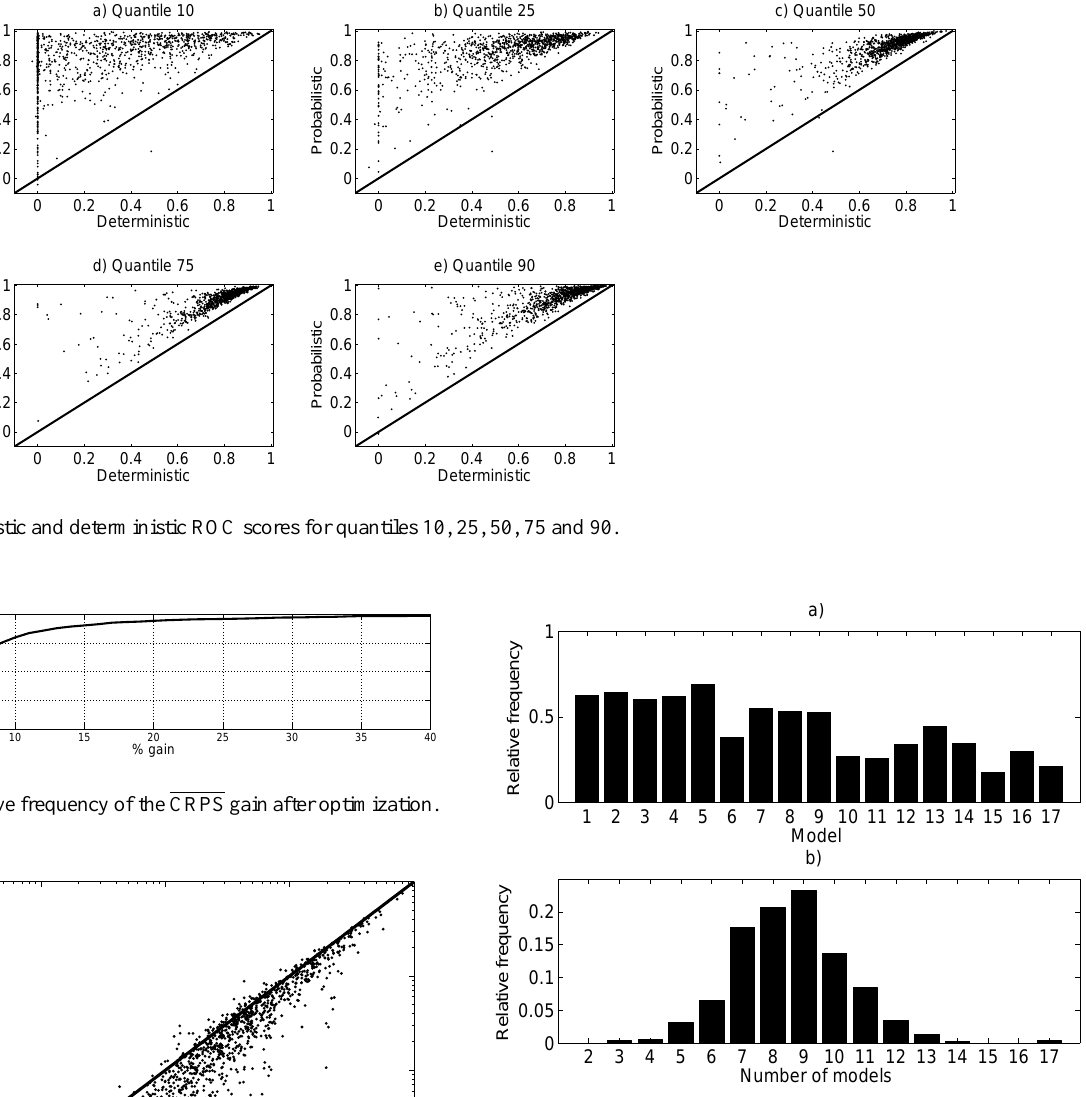
Fig. 13. Relative frequency of (a) the presence of each model in the optimized subset, and (b) the number of models in these subsets, for all 1061